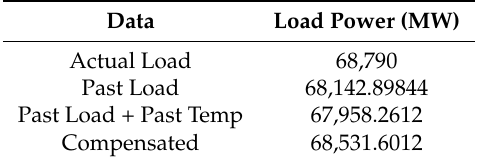
Table 7. Comparison of load forecasting during peak time.